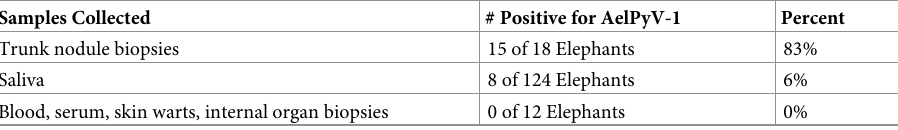
Table 5. Aggregated percentage of samples positive for